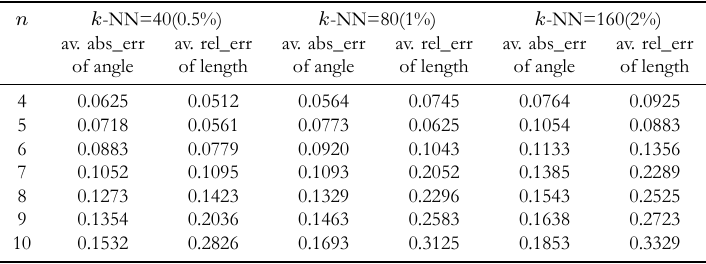
Table 7: Results of ℓ 1 MCDA on four-spoke Gaussian-based high-dimensional radial data sets (with 10% outliers) n